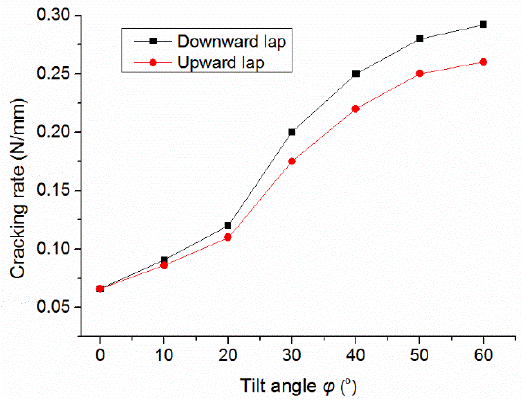
Figure 4. Influence of substrate tilt angle on cracking rate.